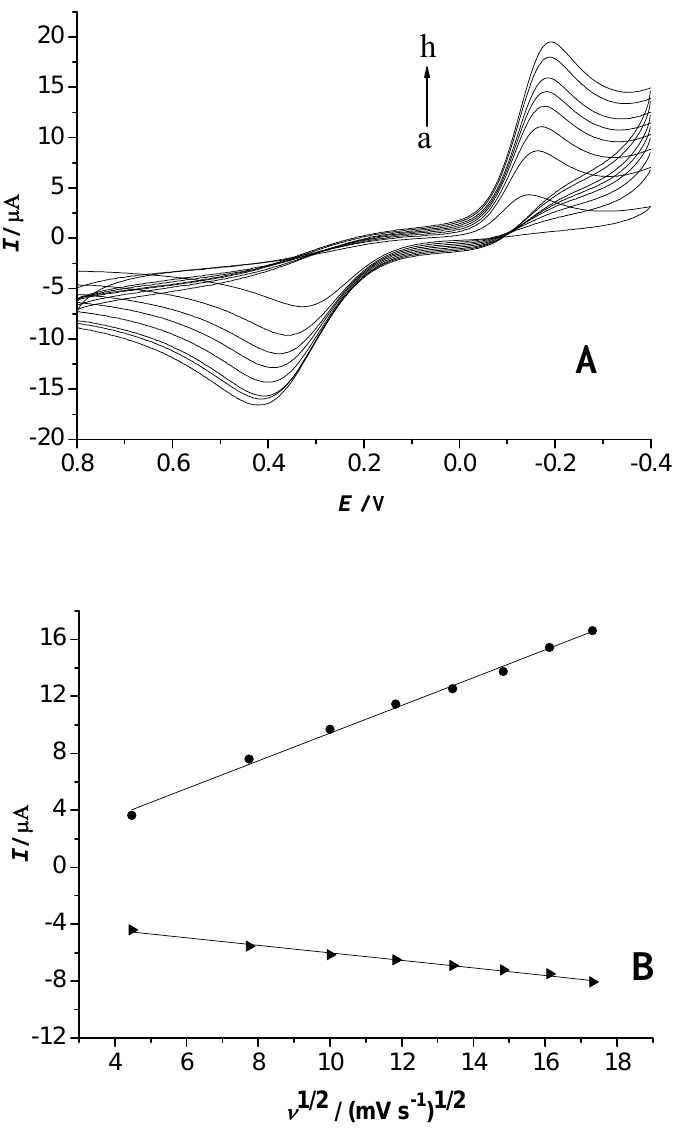
Figure 5. The cyclic voltammograms of Fe rates (from a to h: 20, 60, 100, 140, 180, 220, 260, 300 mV/s) in 0.15 M pH 8.0 PBS containing 6.0 × 10 -4 M HQ (A). (B) the linear relation between peak current and v 1/2